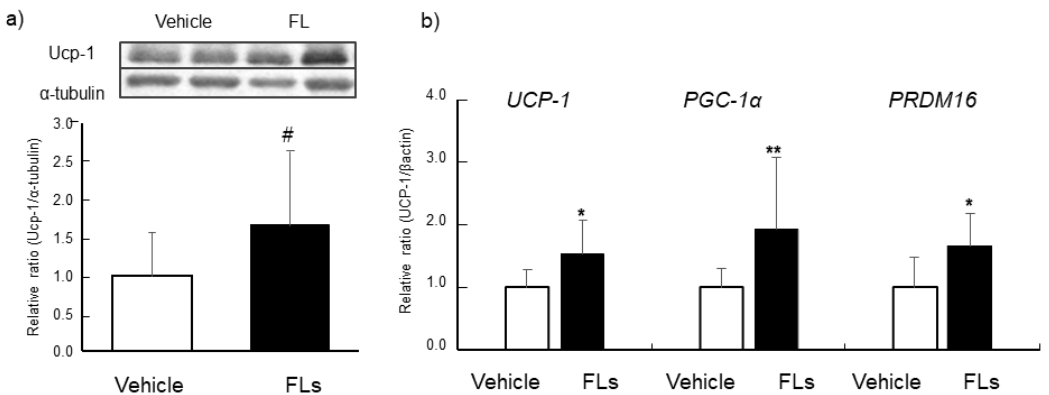
Figure 3. The impact of repeated oral administration of 50 mg/kg flavan-3-ol (FL) s on mice brown adipose tissue (BAT). Ucp-1 levels determined by Western blotting ( a ), mRNA expressions of UCP-1, PGC-1 α and PRDM16 ( b ). The values represent the mean ± standard deviation (each group, n = 11). # p < 0.1, * p < 0.05, ** p < 0.01 (Student’s t-test).